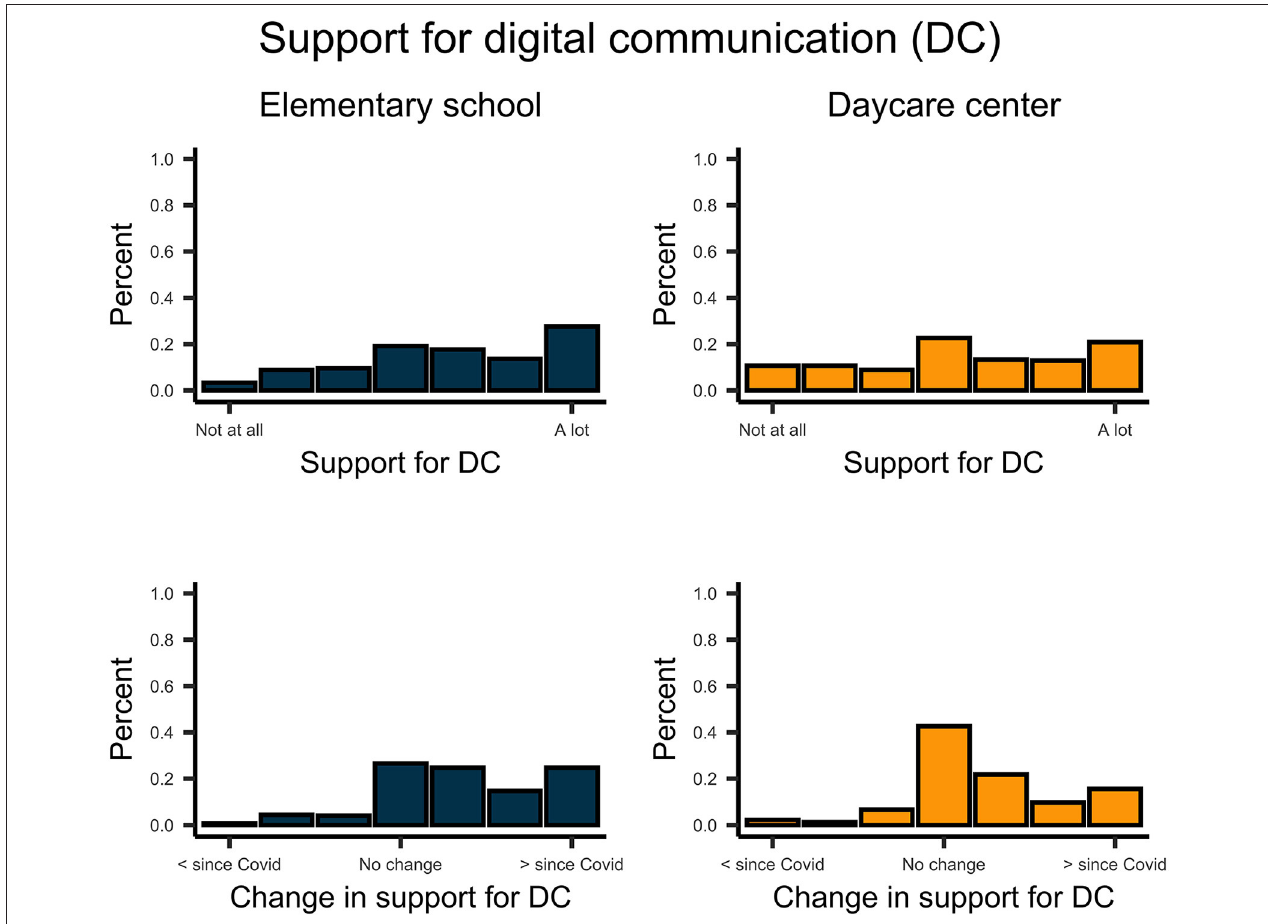
FIGURE 6 | Upper plots indicate the support of parents for digital communication to school- and preschool-aged children. Lower plots indicate the change of this support since the COVID-19